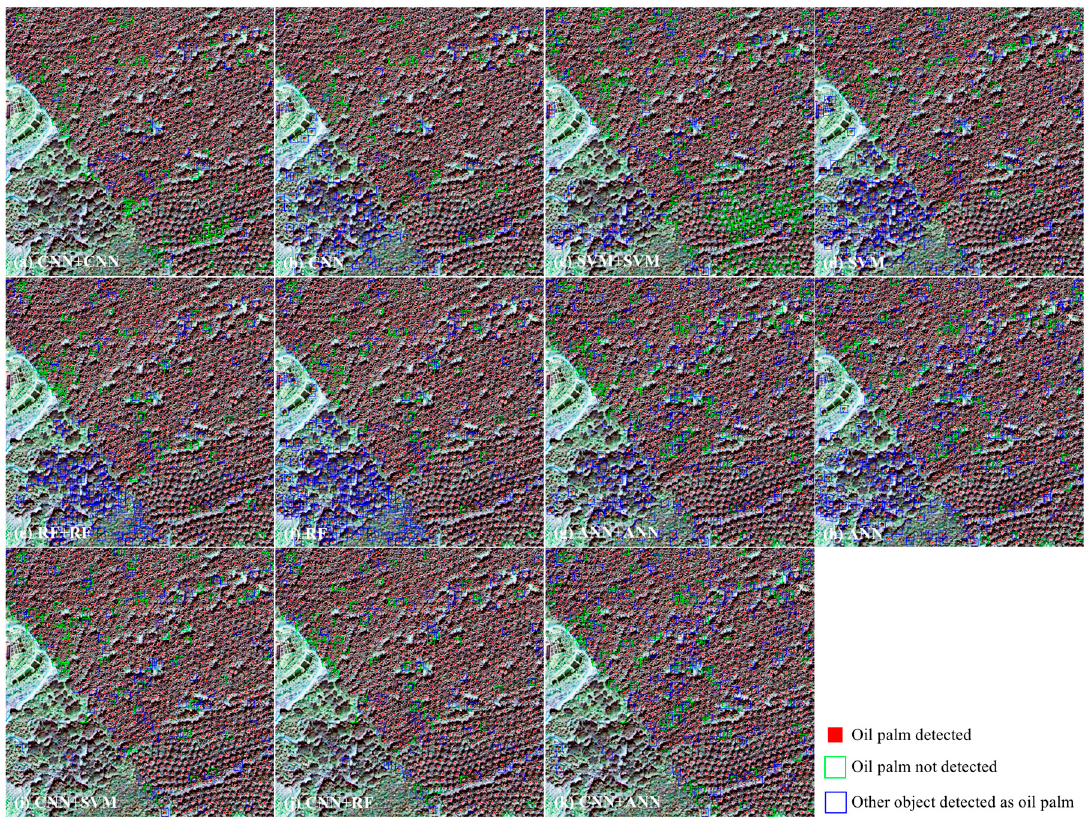
Figure 9. The image detection results of all methods ( a – k ) in Region 4.